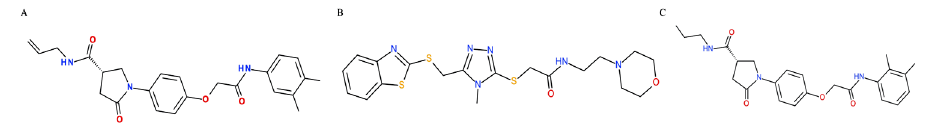
Fig 11. 2D structures of the hit compounds.